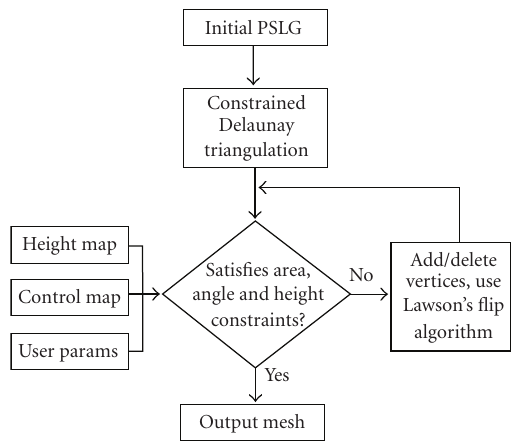
Figure 1: Proposed terrain-generation algorithm.